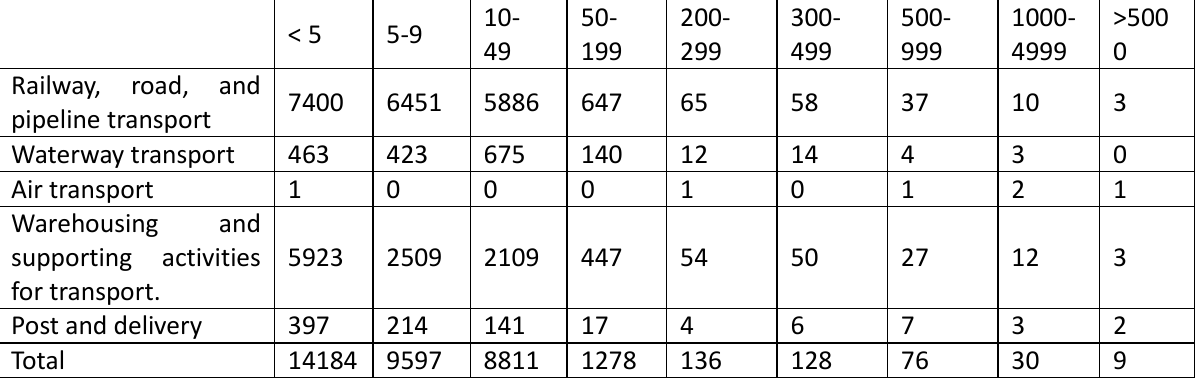
Table 1. The logistics industry by human resources size in Vietnam (source: General Statistics Office of Vietnam, 2018